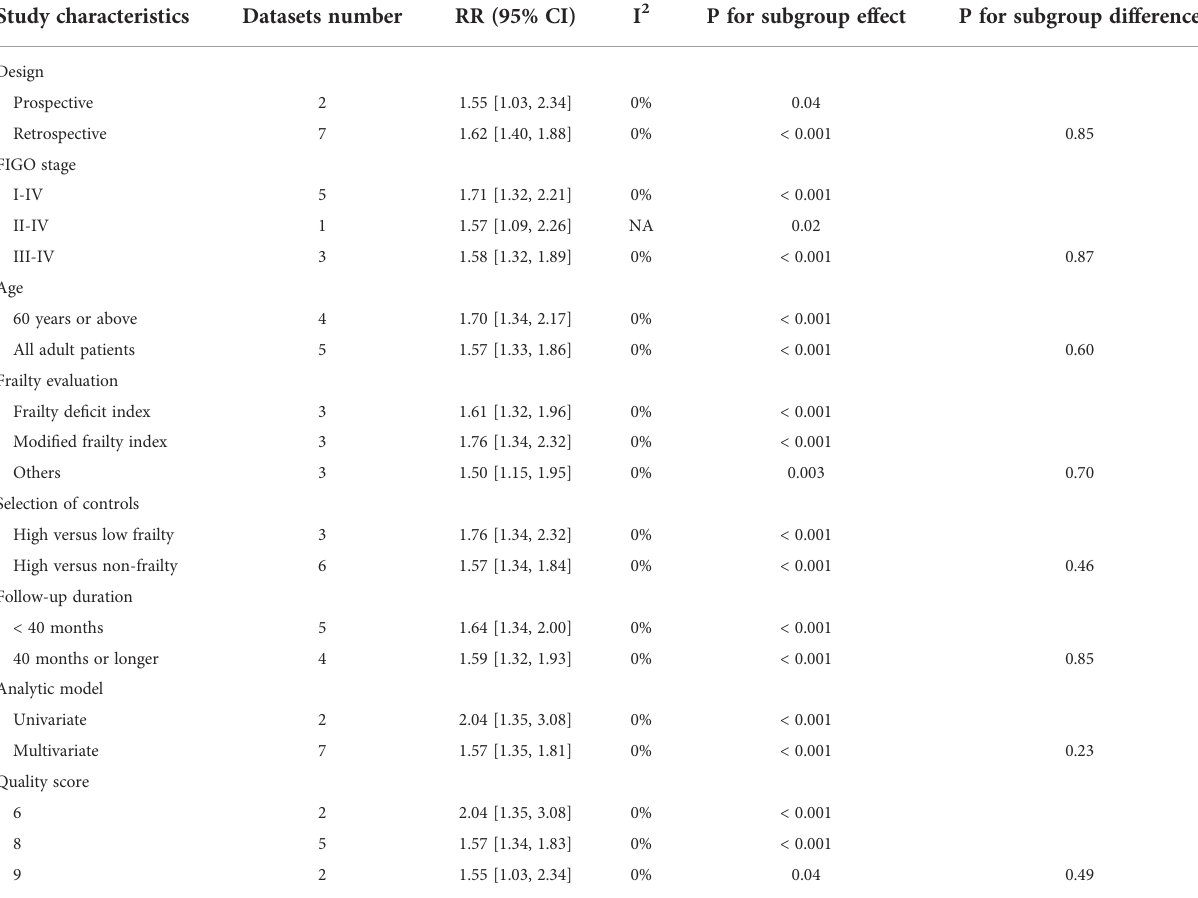
TABLE 3 Subgroup analyses for the association between frailty and overall survival in patients with